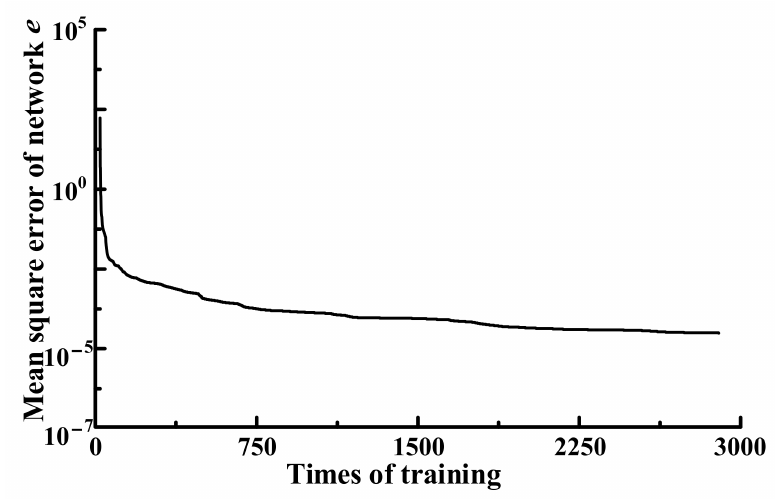
Figure 17. Training performance of the neural